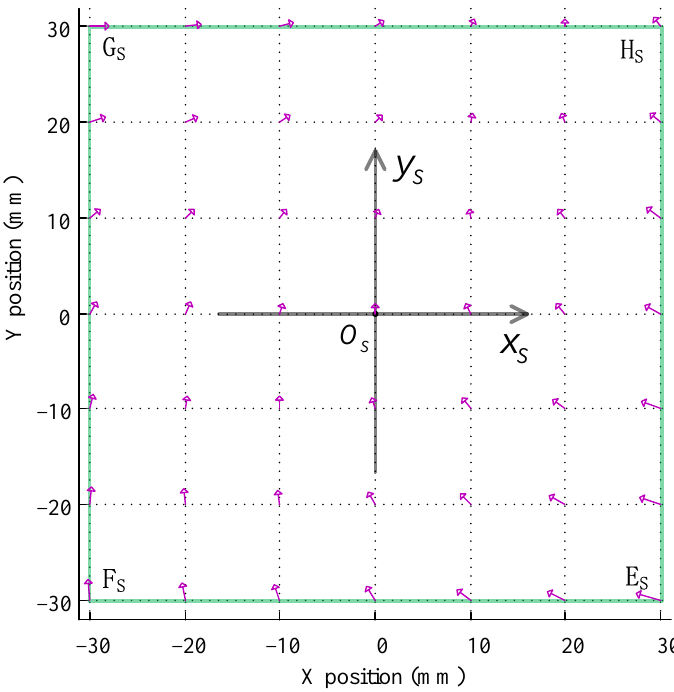
Figure 11. Distribution of the residual of the IMC linear velocity on the sensor plane.